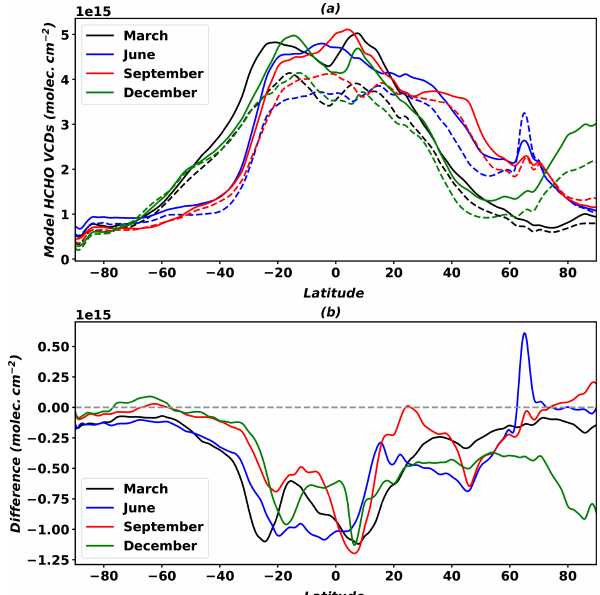
Figure 9. Simulated HCHO vertical column densities used in OMHCHO (solid lines) and the GEMS algorithm (dashed lines) for background correction (a) , and absolute differences of model results between the GEMS algorithm and OMHCHO (b)